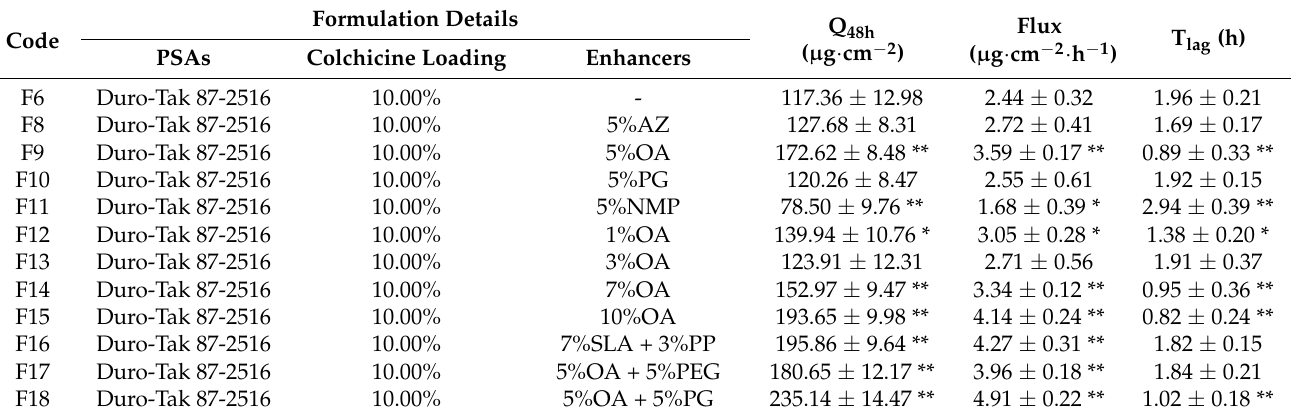
Table 5. Pharmacokinetic parameters of colchicine in plasma following transdermal (6.4 mg/kg) and oral (0.6 mg/kg) administration in rats (mean ± SD, n = 6).